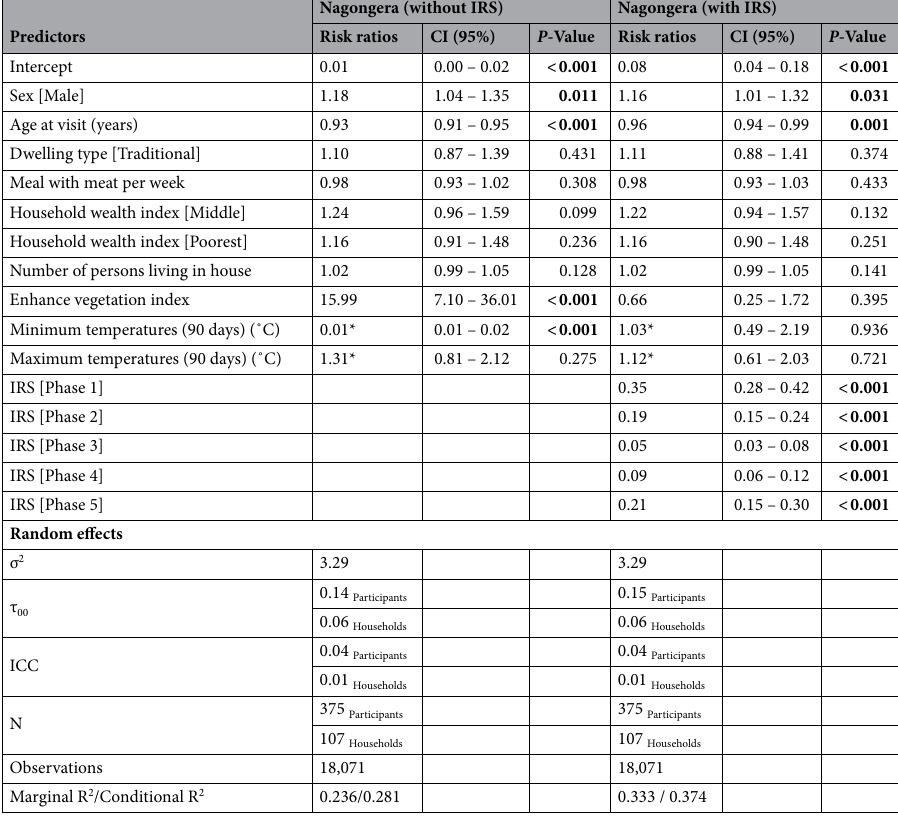
Table 2. Summary of GLMM models for Nagongera. Significant values are in bold. *Risk ratio of malaria when the meteorological linear variable changes from its minimum to its maximum